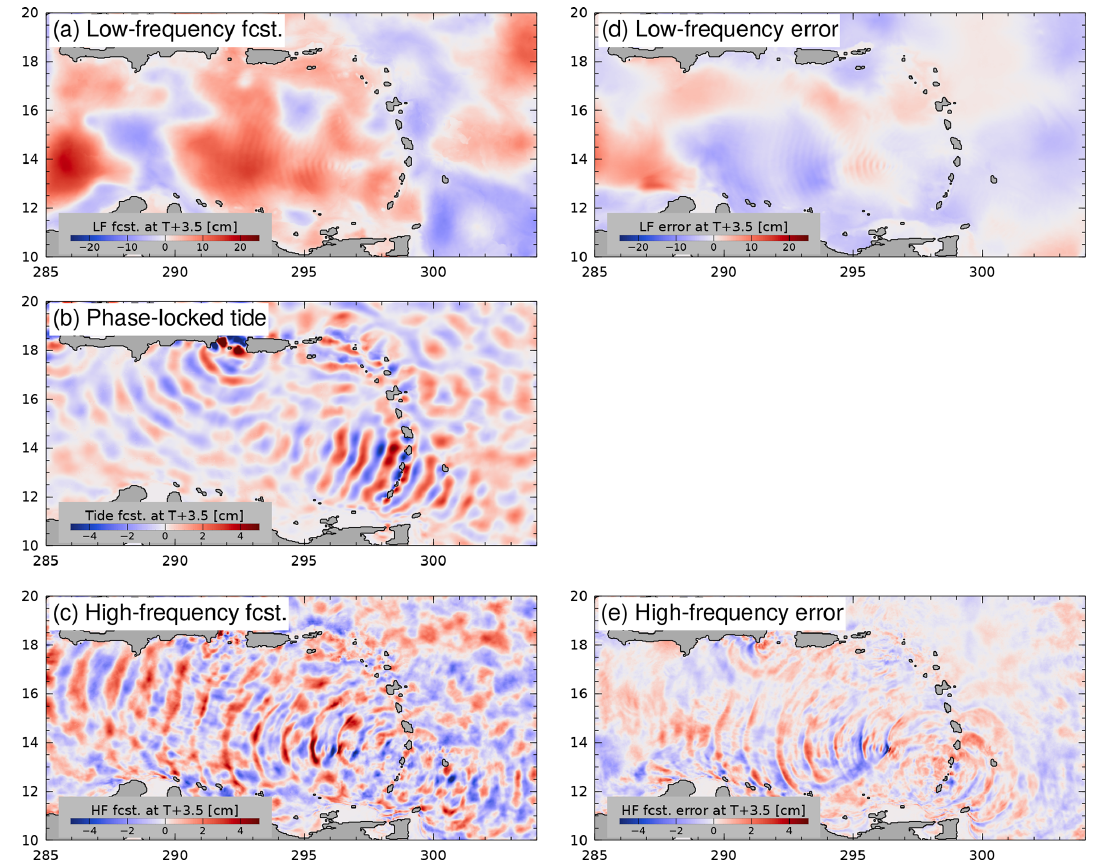
Figure 5. Forecast decomposition and errors for the date, 4 January 2013. For the purpose of analysis, the steric height forecast is decomposed into a sum of three components: (a) low-frequency (24h average), (b) phase-locked tide, and (c) high-frequency (residual). The forecast error is defined as the forecast minus the verifying analysis, valid at the same time. The two components of the forecast error are (d) the low-frequency component and (e) the high-frequency component; the phase-locked tide is identical in the forecast and the analysis. Note the different color scales shown for the high- and low-frequency